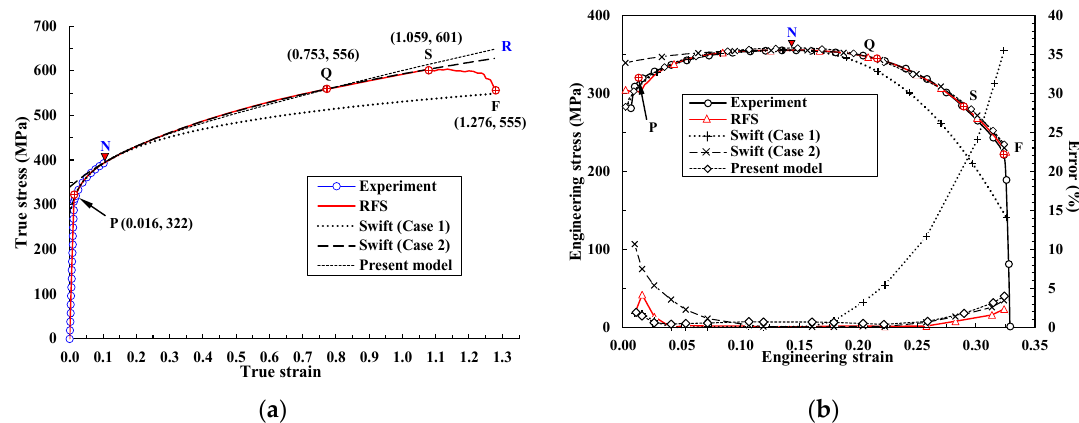
Figure 6. Flow curves of RFS, Swift models (Cases 1 and 2), and the present model and comparison of their predictions with experimental tensile test: ( a ) True stress–strain curves; ( b ) engineering stress–strain curves.